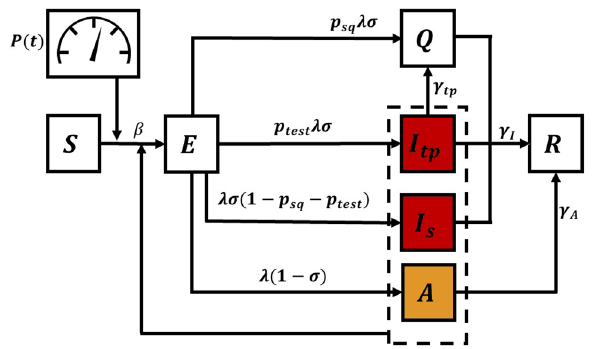
Figure 1. Compartmental model corresponding to Eq. 2. The transition from the S (susceptible) compartment to the E (exposed) compartment is affected by the population densities S ( t ), I tp ( t ) , I s ( t ) , A ( t ) and by the time- varying control input P ( t ). The dashed lines enclose the infectious